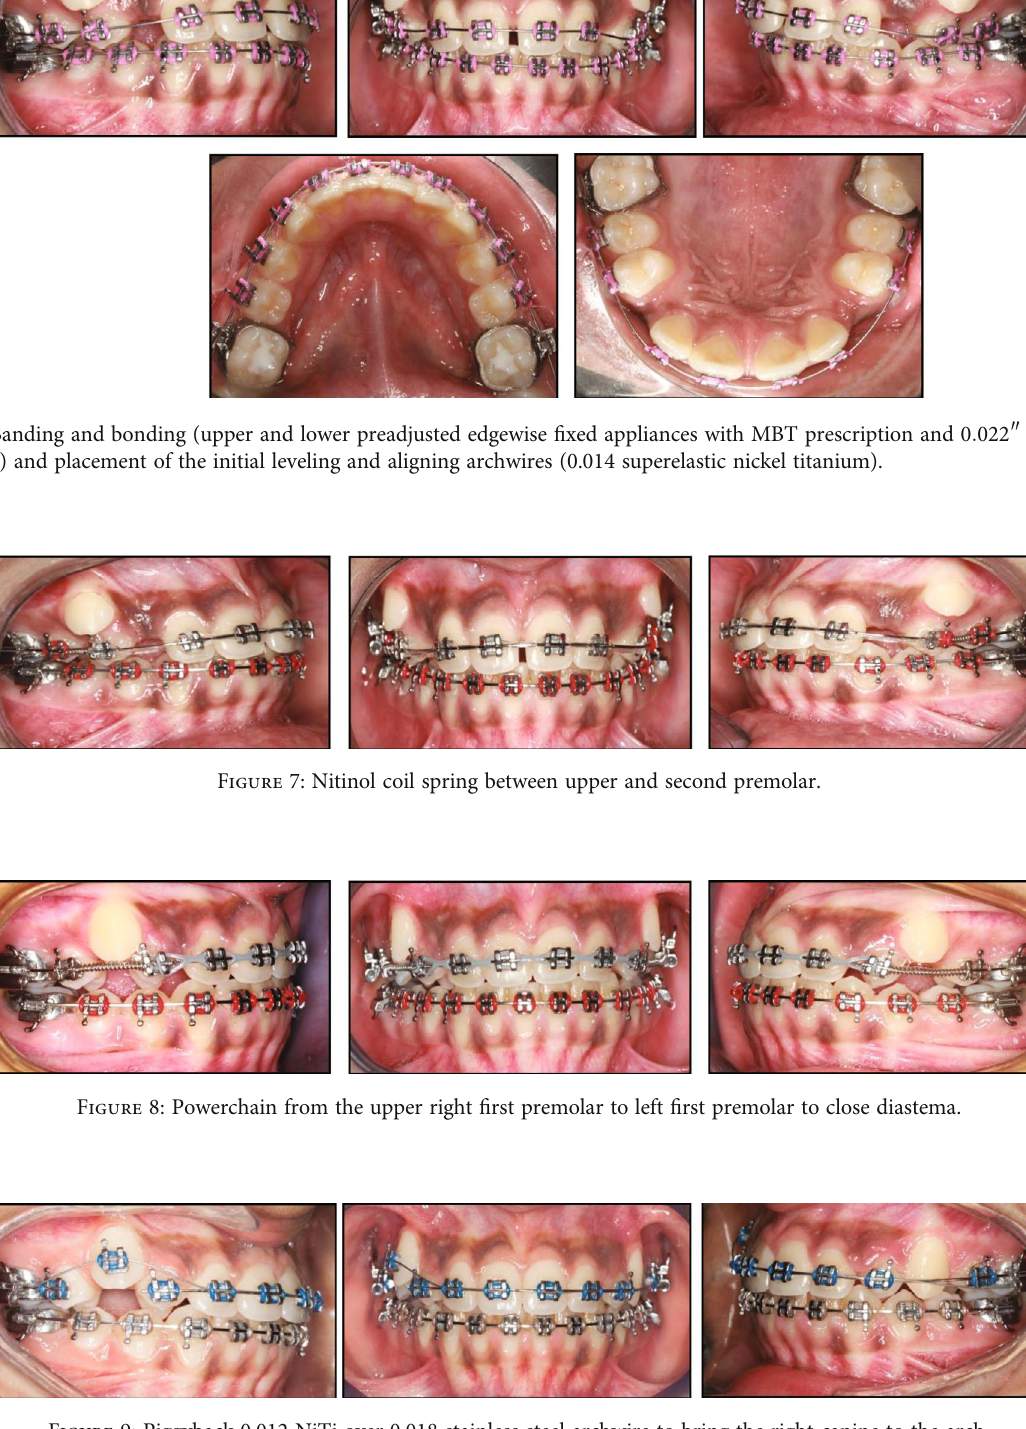
Figure 9: Piggyback 0.012 NiTi over 0.018 stainless steel archwire to bring the right canine to the